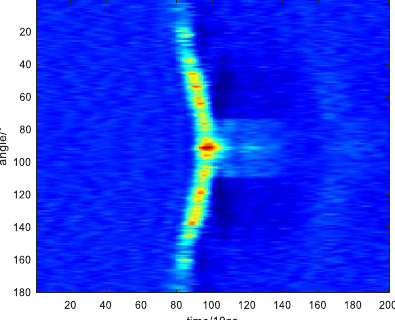
Remote Sens. 2022 , 14 , x FOR PEER REVIEW Figure 10. Converted projection data in complete angle. Figure 10. Converted projection data in complete angle.